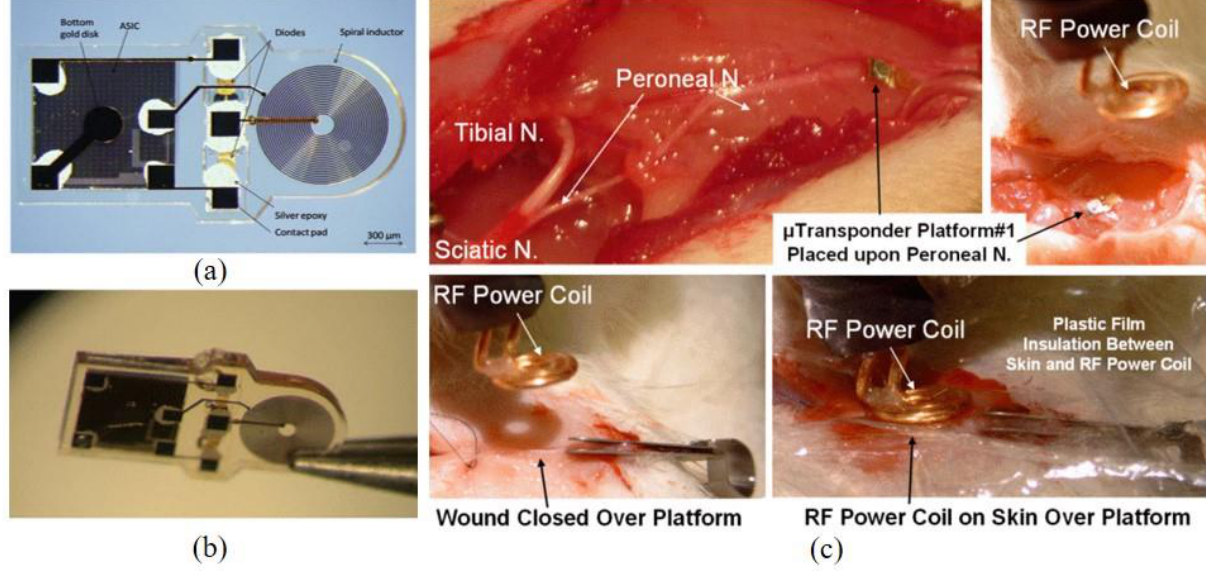
Figure 15. Photomicrographs of the fabricated wireless neurostimulator: ( a ) Conductive epoxy was applied to the socket contact pads, and a couple of Schottky diodes and the ASIC chip were cemented; ( b ) the device was completely sealed by SU-8 and released from the substrate; and ( c ) Acute surgical rat preparation for subcutaneous placement of microstimulator implants to record the cortical response to wireless stimulation of the hind limb. © 2013 IEEE. Reprinted from Cho et al. [75] with permission.